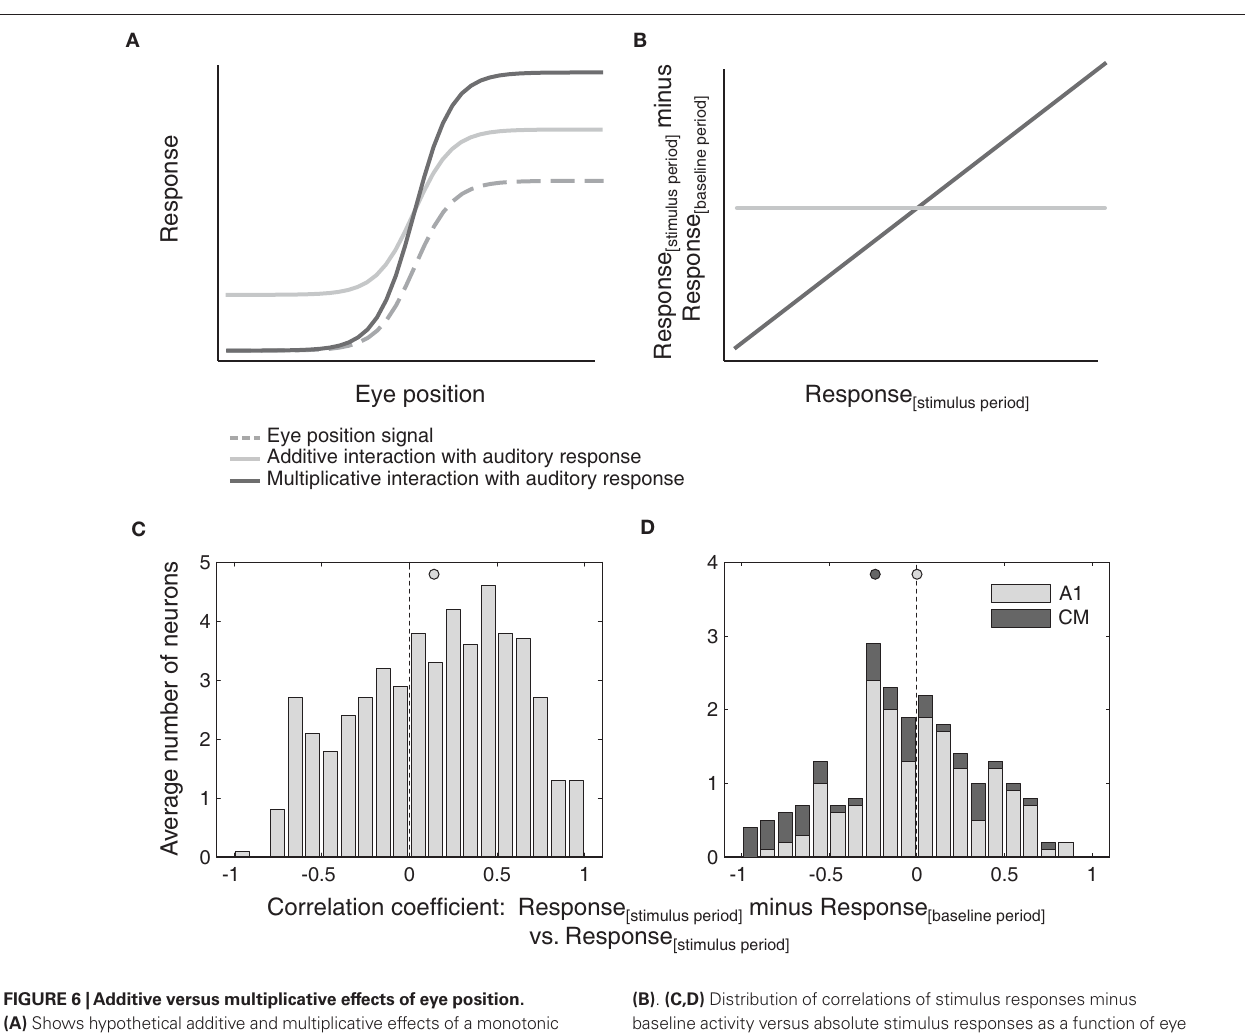
FIgure 6 | Additive versus multiplicative effects of eye position. (A) Shows hypothetical additive and multiplicative effects of a monotonic eye position signal on an auditory response. The resulting correlation between the response difference (stimulus minus baseline) and the stimulus period response as a function of eye position is shown in